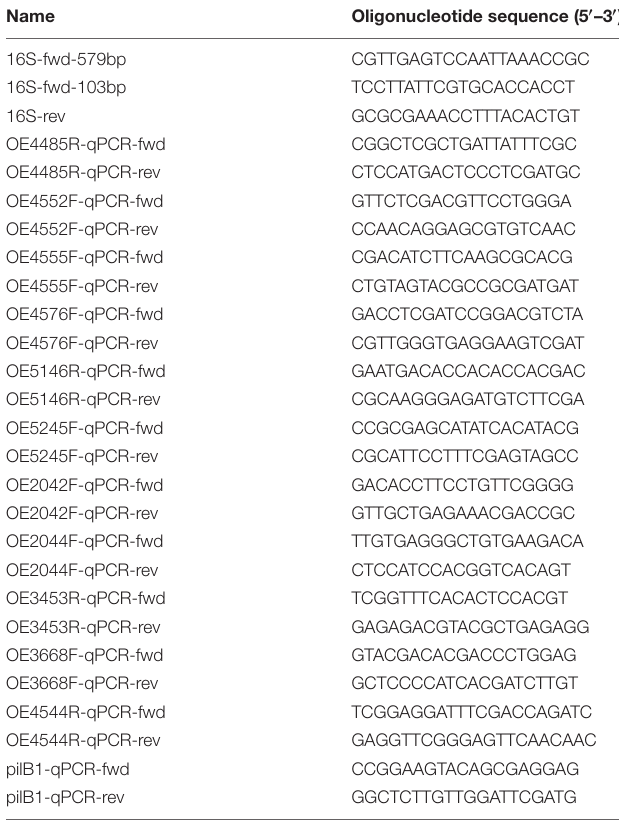
TABLE 1 | Oligonucleotides used for PMA-qPCR and qRT-PCR analyses. Name Oligonucleotide sequence (5 (cid:48) –3 (cid:48)